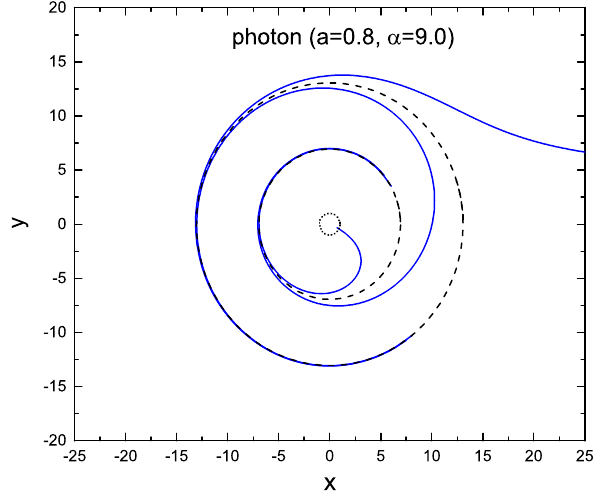
Fig. 3 The trajectory of a photon in the case of the Kerr-MOG black hole with a = 0 . 8 and α = 9. As a photon approaches the ring singular- ity from the inner horizon, the trajectory of a photon explicitly shows that the photon is bending rapidly to the singularity compared to the case shown in Fig.